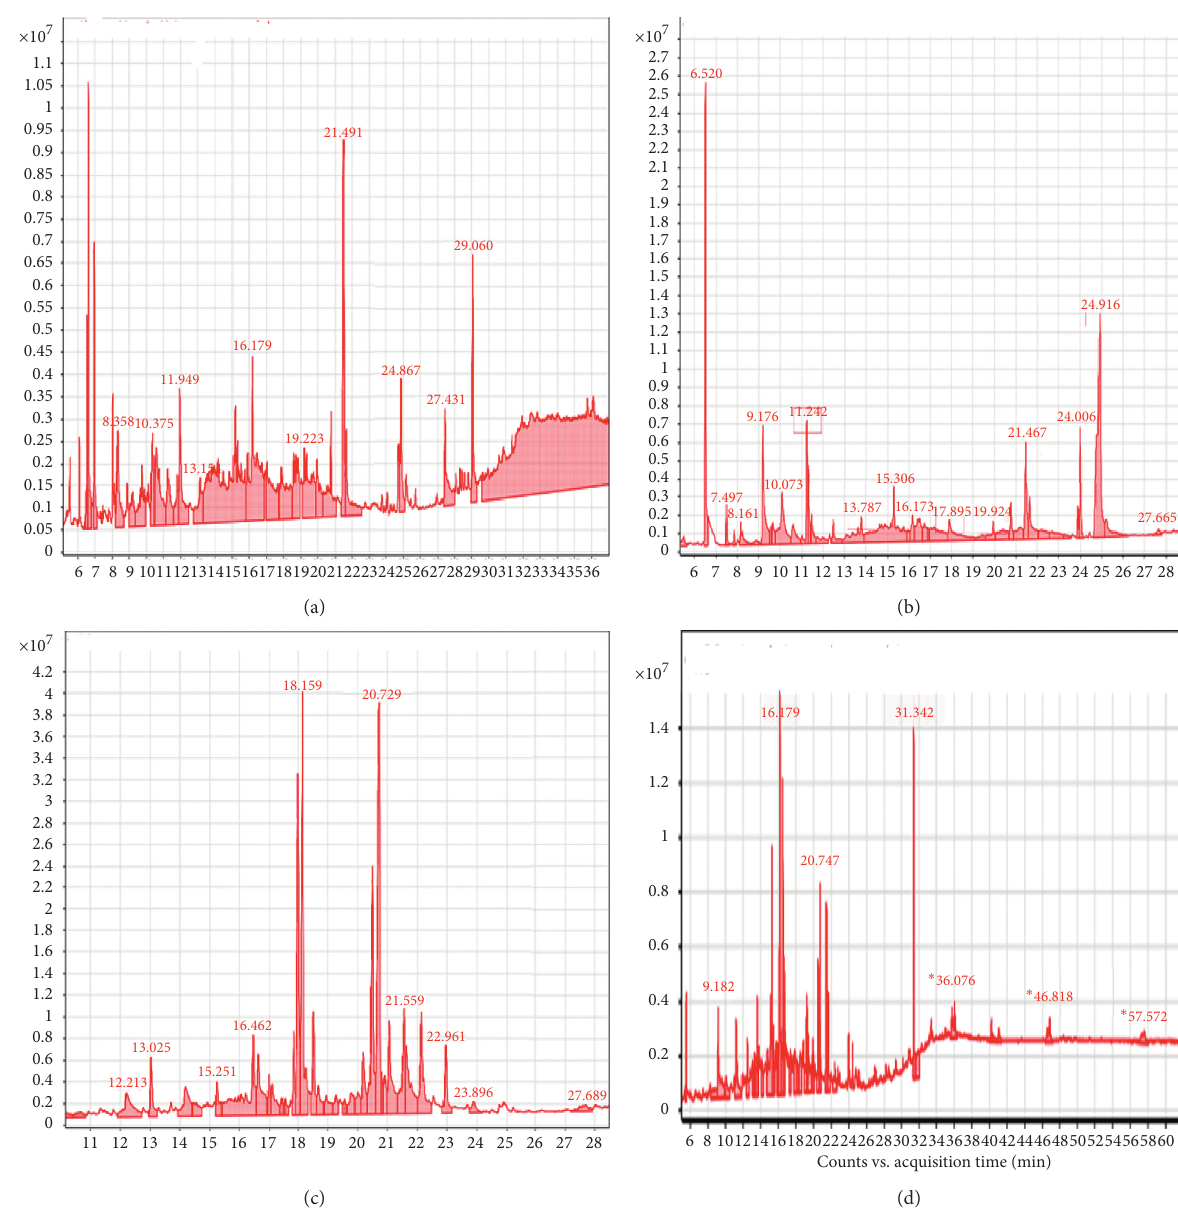
Figure 3: GC-MS spectrum of of methanolic plant extract: (a) marjoram; (b) coriander seeds; (c) chamomile; and (d) guava leaves. Table 1: Some of the chemical components identified in methanolic extract by